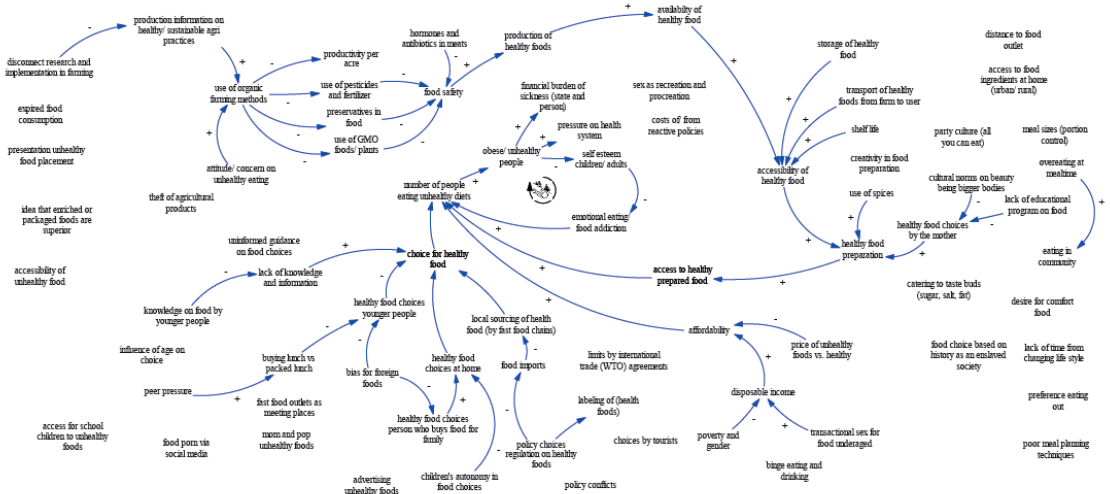
Figure A1. Jamaica workshop room 1 preliminary causal loop diagram for unhealthy eating.